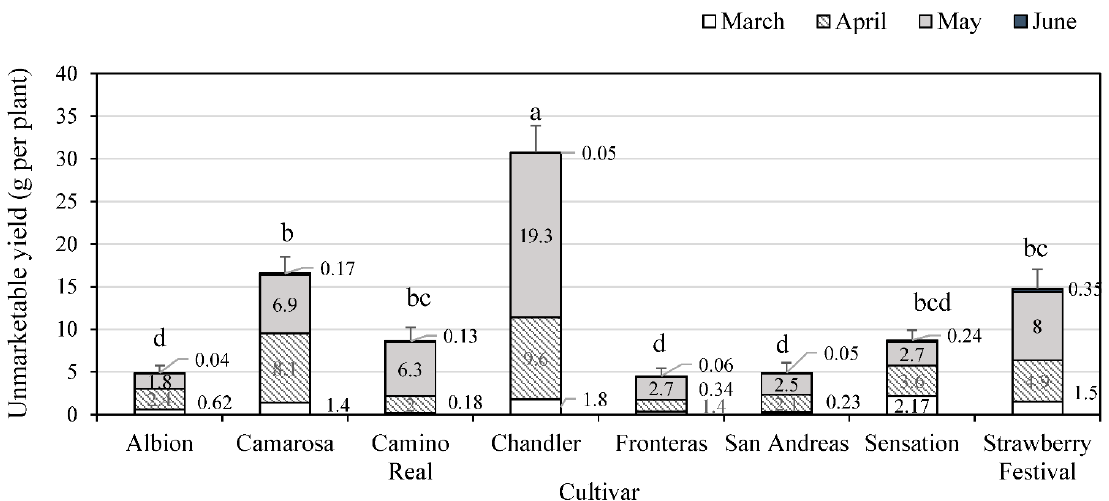
Figure 5. Monthly and total unmarketable yield of six June-bearing (“Camarosa”, “Camino Real”, “Chandler”, “Fronteras”, “Sensation”, and “Strawberry Festival”) and two day-neutral (“Albion” and “San Andreas”) strawberry cultivars grown with black or red plastic mulches in a high-tunnel production system in Starkville, Mississippi from November 2017 to June 2018. Strawberry fruits that were misshapen, disease- or insect-damaged, or below 10 g were considered unmarketable yield. Different lowercase letters on top of each bar indicate a significant difference in total unmarketable yield among cultivars using Tukey’s HSD test at p ≤ 0.05. Compared to the red mulch, black mulch increased marketable yield by 11.2% in March, but decreased marketable yield by 9.7% in May (Table 4). Red mulch resulted in higher unmarketable yield than black mulch in March and May. There was an interaction between cultivar and mulch type in unmarketable yield in March and May, where red mulch increased unmarketable yield in “Chandler” compared with black mulch, but resulted in similar unmarketable yields in other cultivars (data not